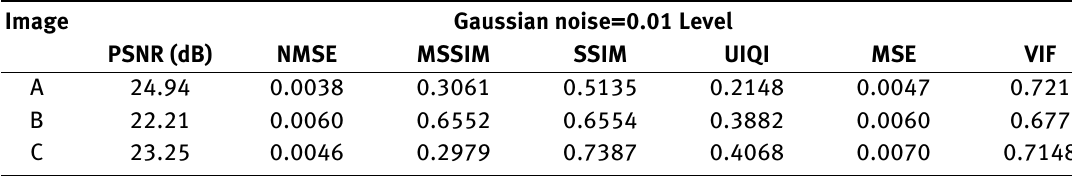
Table 2: Performance of modified fuzzy set filter by adding 0.01 level of Gaussian noise Image Gaussian noise=0.01